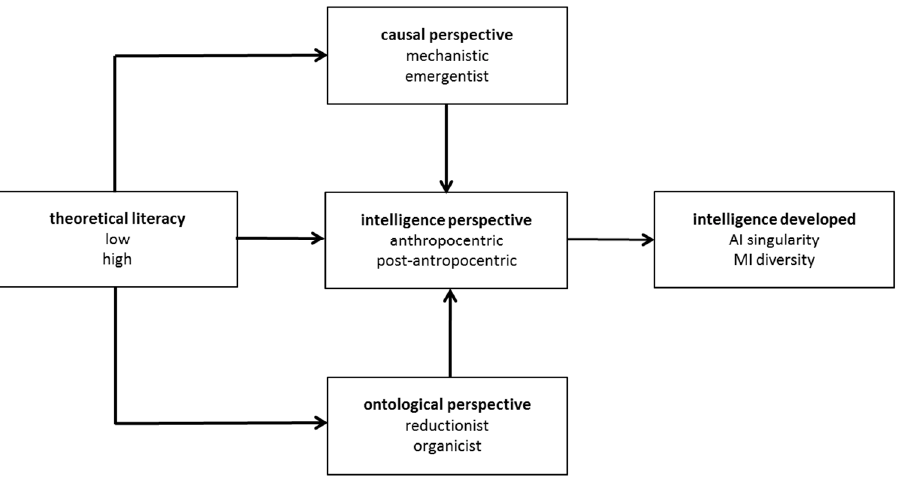
Figure 2. Conceptual Framework.